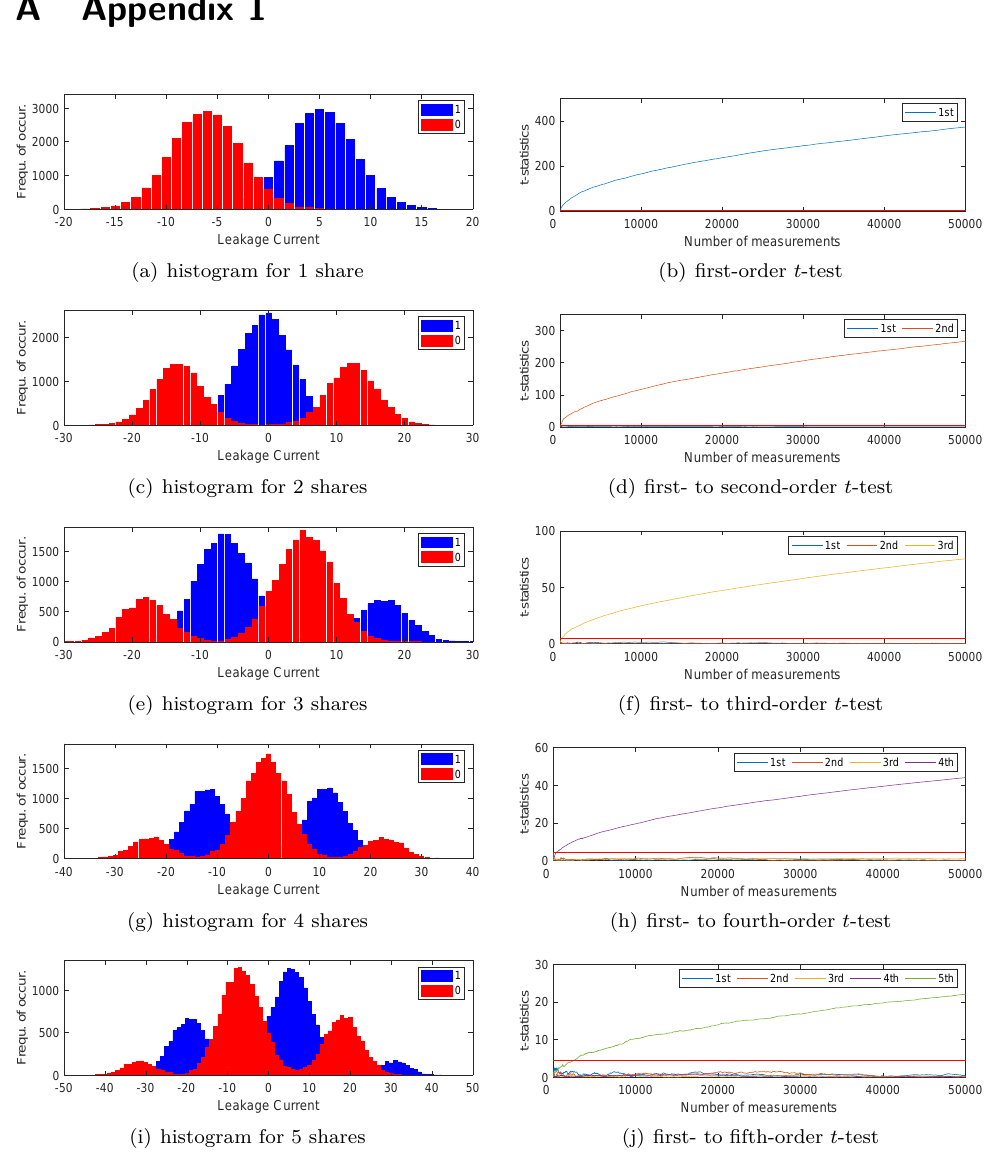
Figure 19: Same experiments as in Figure 8, but without stopping the clock and instead running an LFSR-based PRNG during the